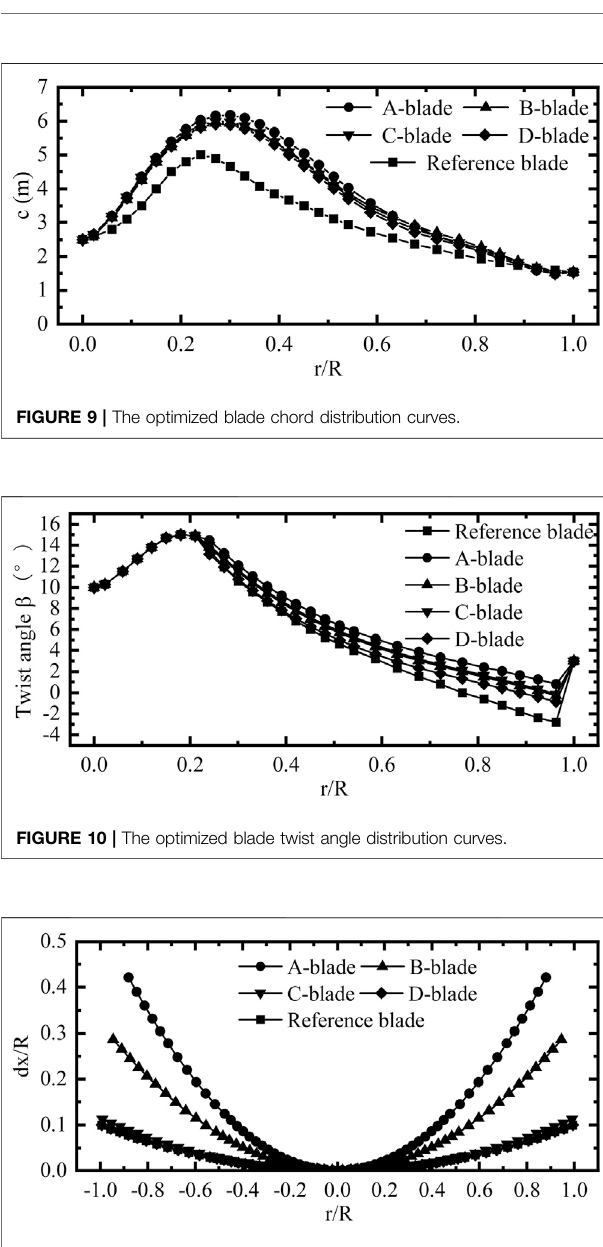
FIGURE 11 | The optimized blade pre-bending distribution curves.